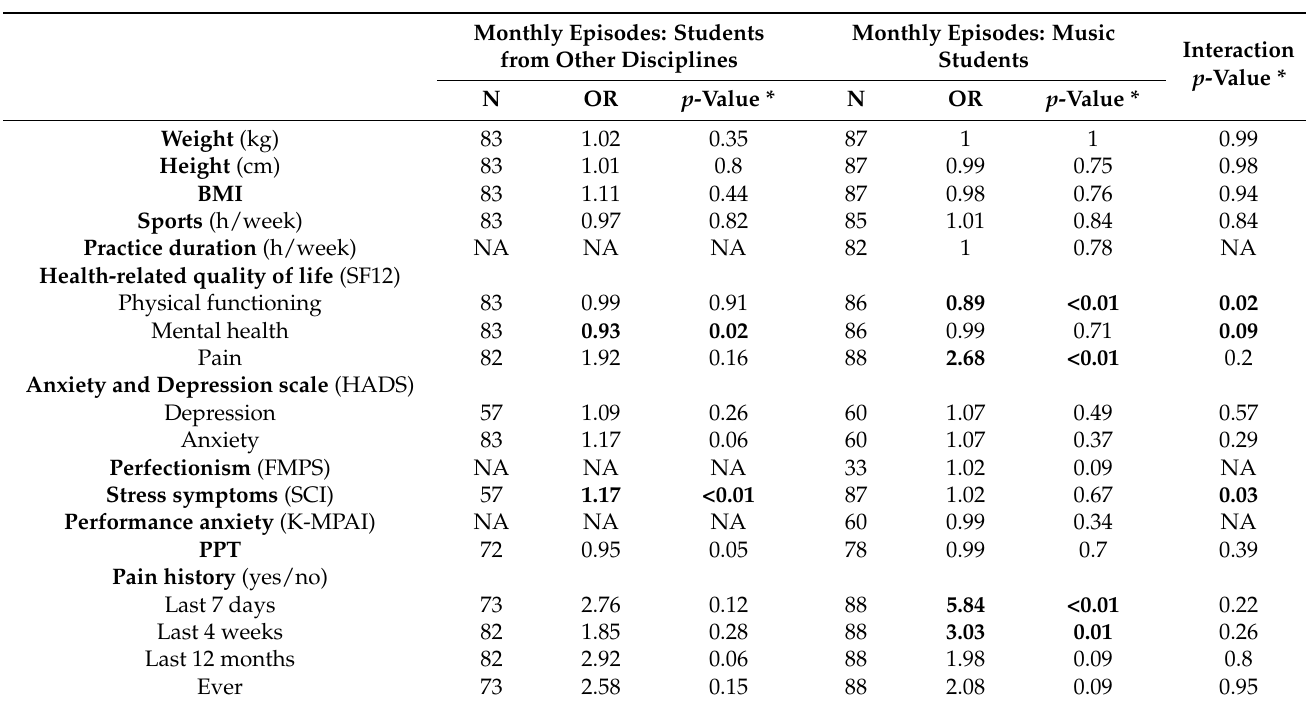
Table 4. Univariate longitudinal analysis of risk factors (predictors) for developing MHCs. p -values of the interaction terms indicate whether ORs of the predictors are significantly different between